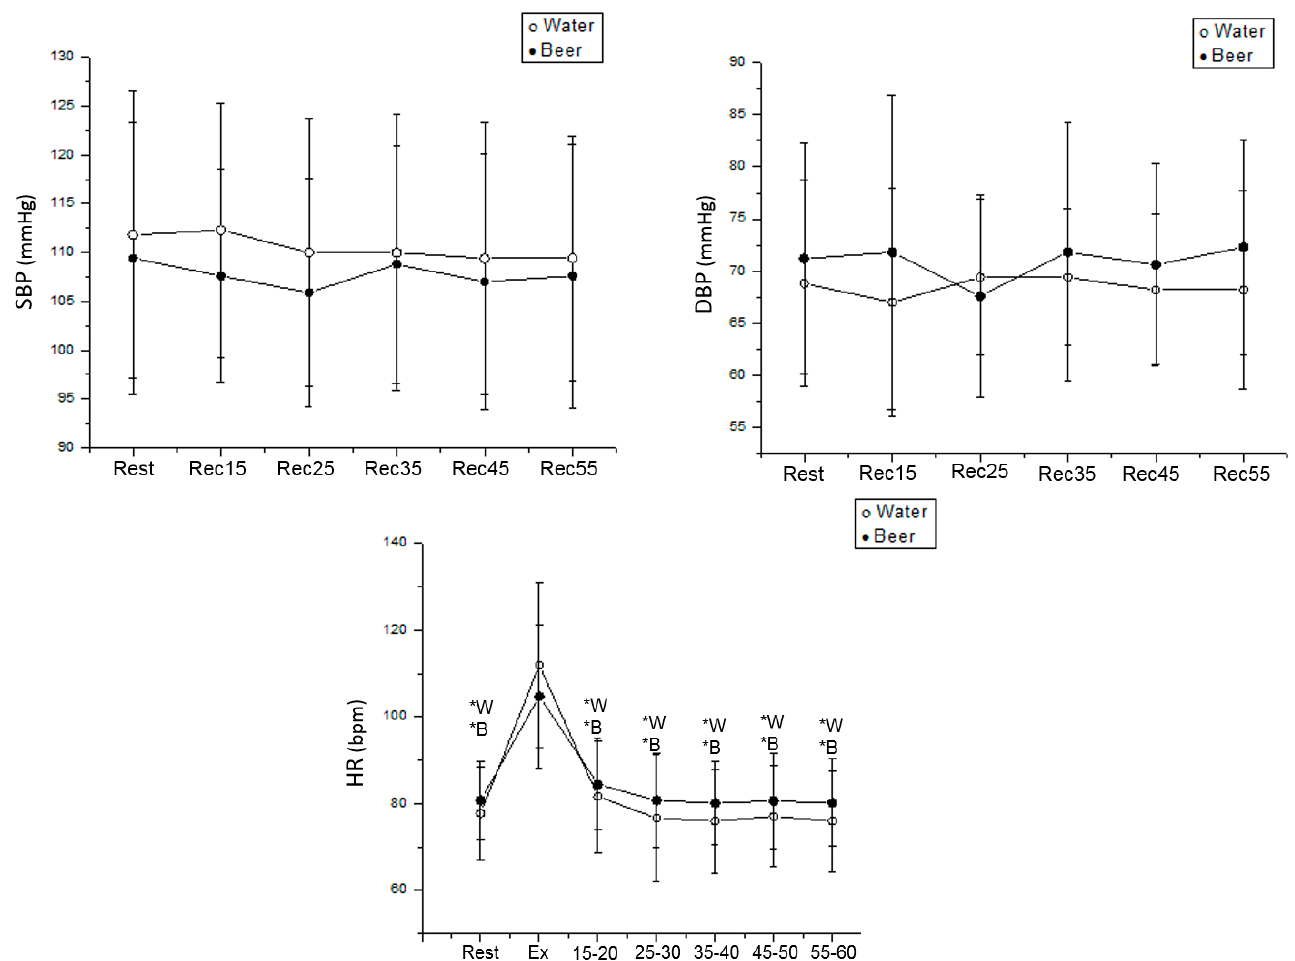
Figure 3. HR, SBP and DBP values were obtained at rest and during recovery from moderate aerobic exercise protocol in men. *W: Values with significant differences in relation to exercise ( p < 0.01) for water protocol; *B: Values with significant differences in relation to exercise ( p < 0.01) for beer protocol.